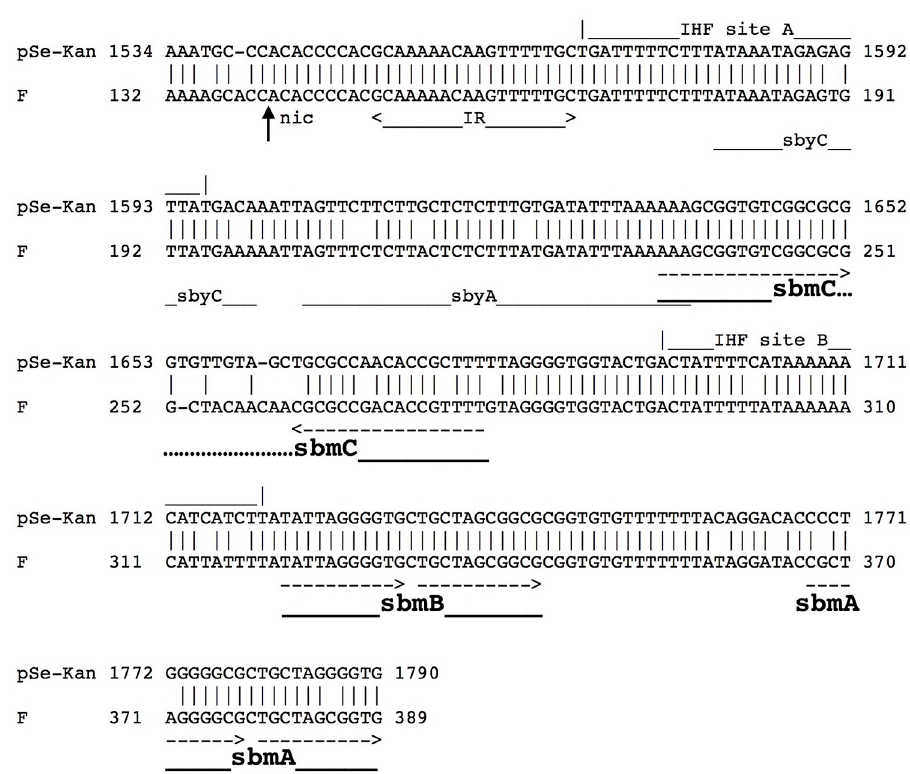
Fig 5. Alignment of oriT(F) of pSe-Kan to F. Relaxase cleavage site, nic, is marked by an upward arrow; the nicked strand is complementary to the sequence shown. IHF binding sites (A and B) are shown as lines above the alignment. TraM binding sites are marked by a dashed line with arrow. SbmA/B/C , TraM binding sites; sbyA/sbyC, TraY binding sites. Sites were marked based on [40, 41].